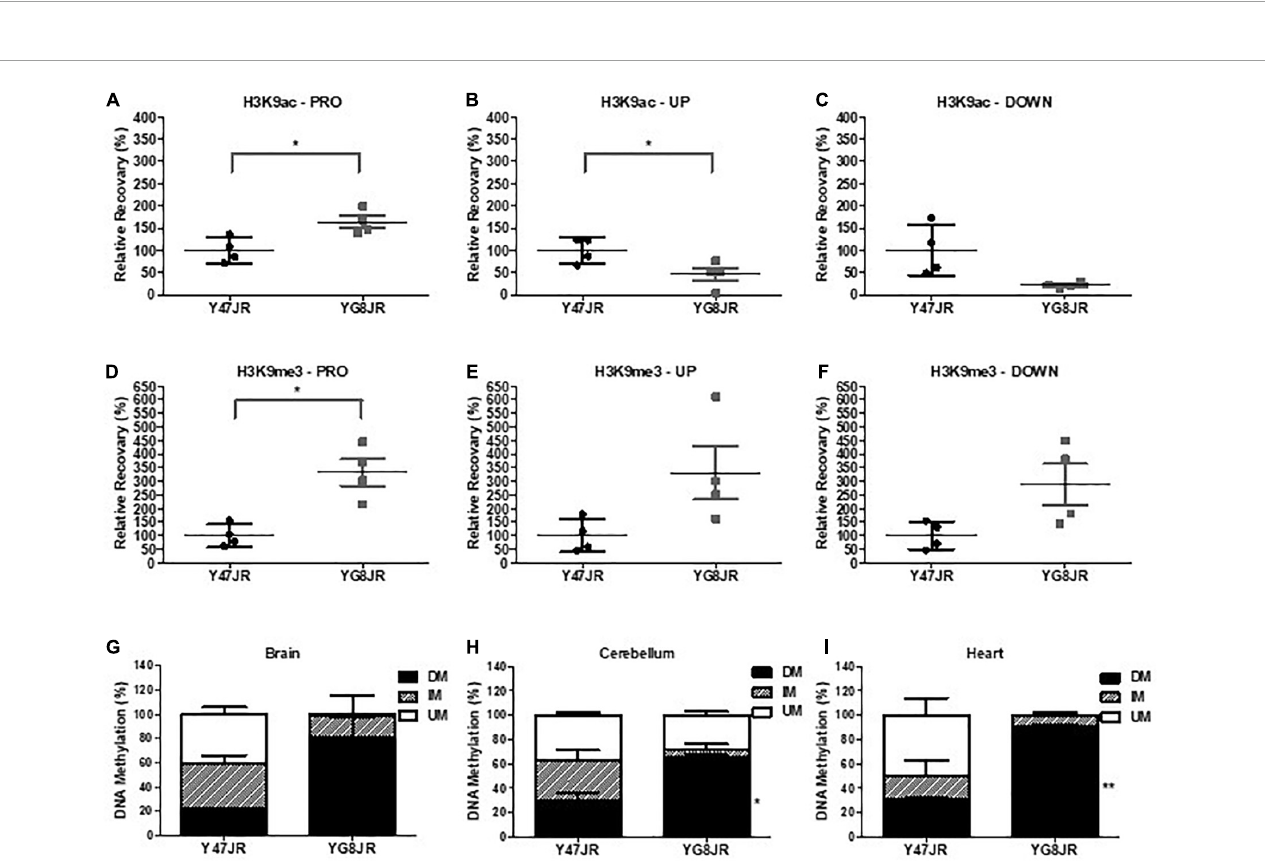
FIGURE5 Epigenetic changes within the FXN gene and aconitase activity assay. (A–F) ChIP quantitative PCR analysis on cerebellum tissues of YG8JR and Y47JR tissues for (A–C) acetylated (H3K9ac) and (D–F) methylated (H3K9me3) residues within FXN (A,D) promoter/exon1 (PRO), GAA (B,E) upstream (UP), and (C,F) downstream (DOWN) region ( n = 4 mice per group analyzed in triplicates). Results are represented as the relative amount of immunoprecipitated DNA compared with input DNA. YG8JR values were normalized to the Y47JR values that were set as 100%. DNA methylation analysis of CpG U13 in FXN GAA repeat region of DNA from YG8JR FRDA and Y47JR control mice in (G) brain ( n = 2 each group), (H) cerebellum (Y47JR n = 3, YG8JR n = 4), and (I) heart ( n = 2 each group) tissues. DM, densely methylated; IM, intermediately methylated; UM, unmethylated. Asterisks indicate significant differences between YG8JR and Y47JR, assessed by unpaired two-tailed Student’s t -test (* p < 0.05, ** p <